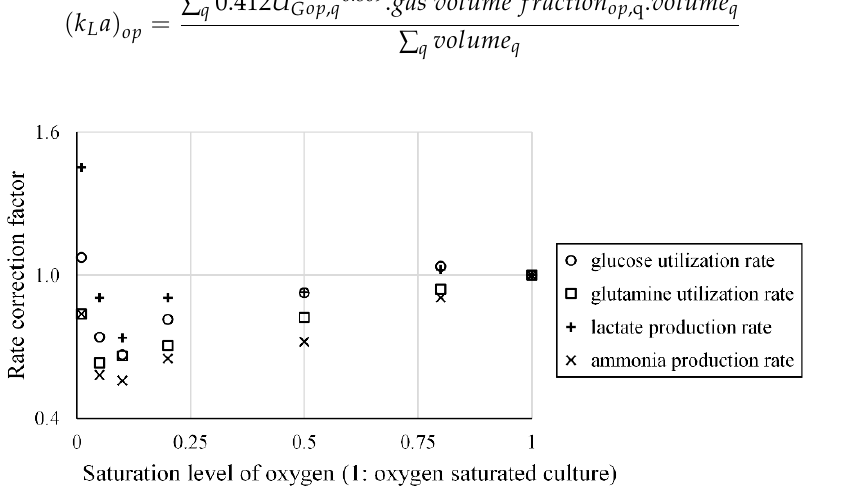
Figure 2. The effect of DO concentration on metabolites’ uptake and production rates.